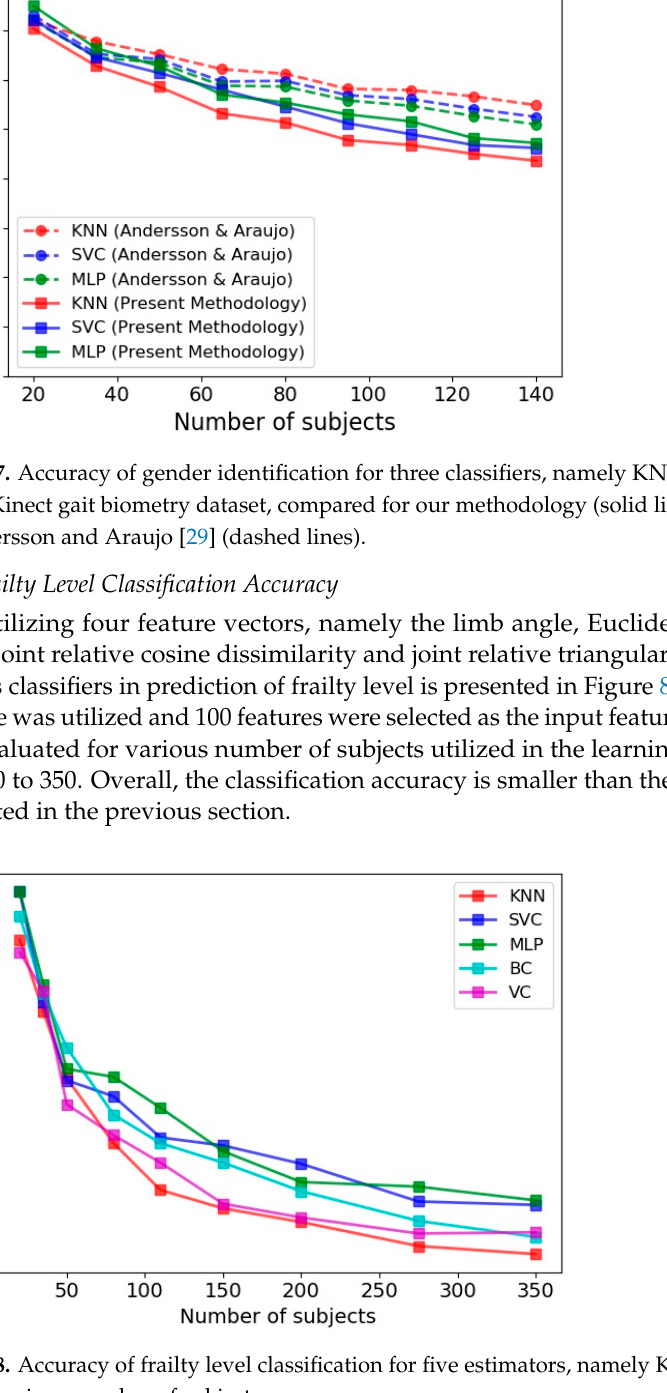
Figure 8. Accuracy of frailty level classification for five estimators, namely KNN, SVC, MLP, BC and VC for various number of subjects. VC for various number of